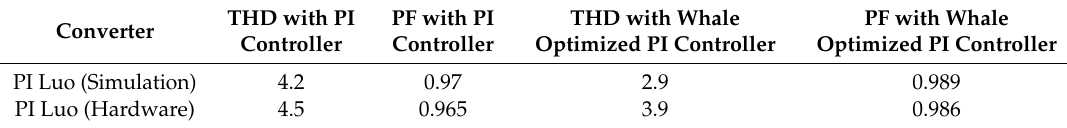
Table 4. Grid current THD and power factor